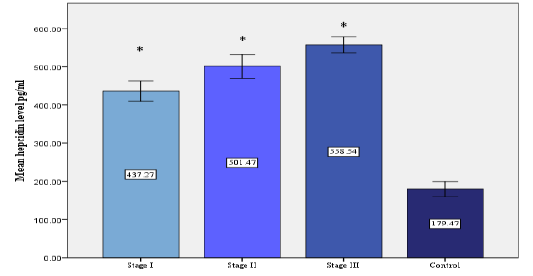
Figure1. Mean value of serum hepcidin among studied groups *= significantly different from control group (p˂0.05) Figure2. Mean value of serum ferroportin among studied groups *= significantly different from control group (p˂0.05). Table 5. Correlation study among studied groups